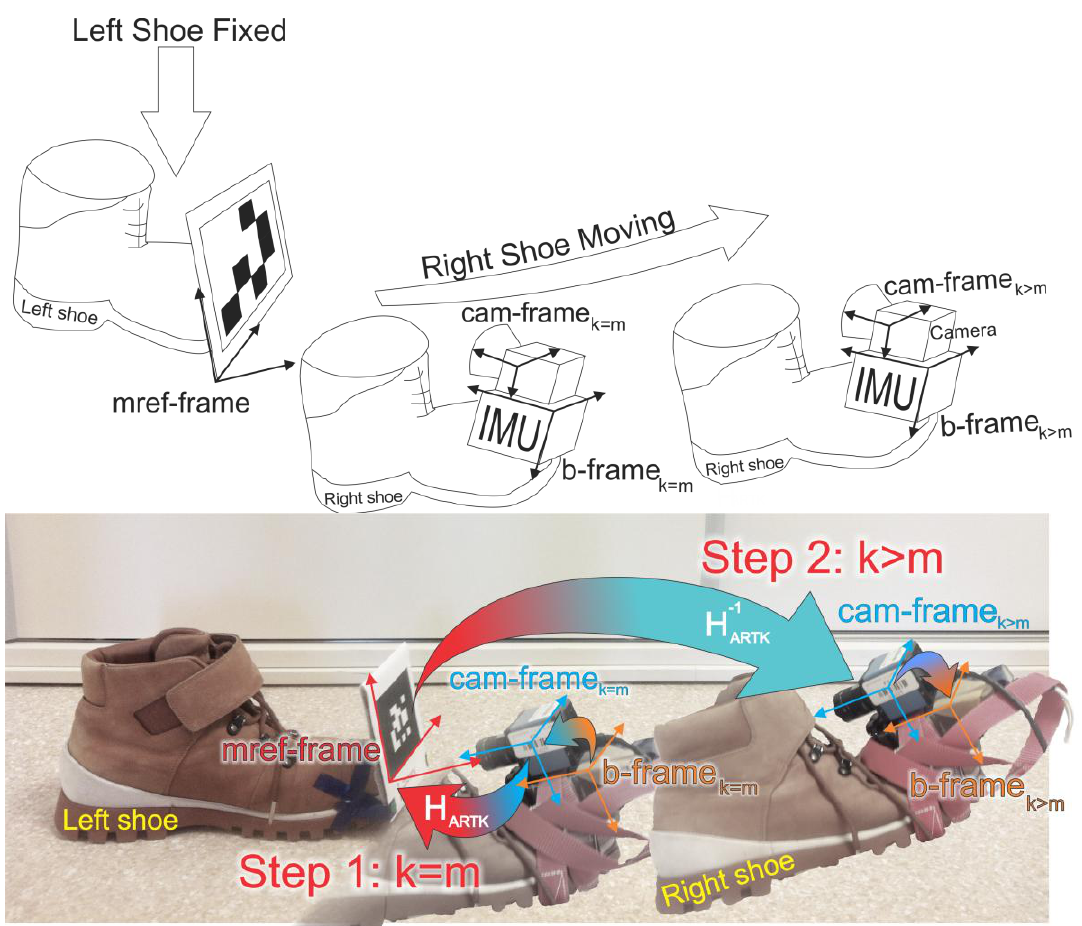
Figure 3. Schematics of our two-step pose calculation process, yielding the IMU position in the navigation frame as the final result. If m denotes the moment when the marker is first seen during the current swing phase, then mref-frame is being defined at time step k = m , while successive b-frames are being calculated at time steps k > m , when the marker is being detected in the acquired video